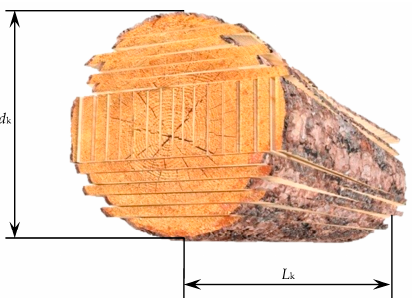
Figure 3. Dimensions and the scheme of sawing a log into the center and side-sawn lumber ( d k —log diameter at its thinner end, L k —log length). In the stage of wood processing, boards with a thickness of 38 mm were produced from the central part of the log (center-sawn lumber). At the same time, from the side part of the logs, boards with a thickness of 25 mm were formed (side-sawn lumber). The center- sawn lumber was the specialized lumber as 38 mm boards intended to produce semi- fi n- ished furniture elements. Three production variants, “A”, “B”, and “C”, were analyzed. Industrial devices and technology were the same in the compared variants; the variable in the cut material e ffi ciency of cu tt ing was the diameter of the log. In this stage, three thick- ness grades of logs were cut and kiln-dried. Figure 4 schematically shows the described production variants. Figure 4. The analyzed variants of the fi rst stage of wood processing (producing the specialized lumber as 38 mm board).